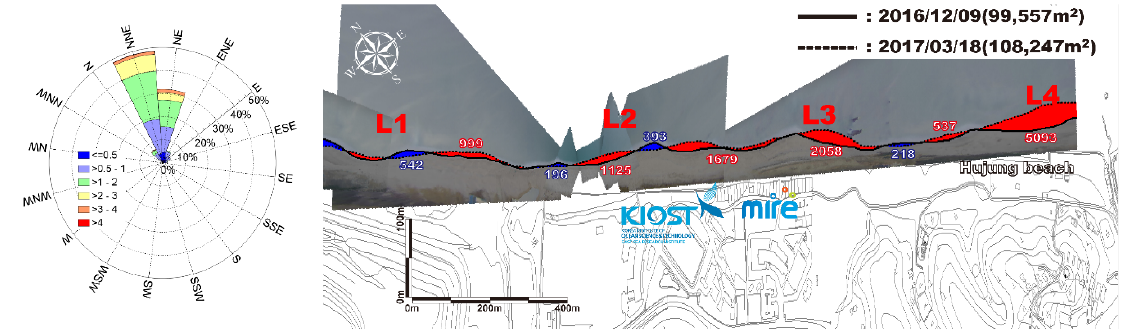
Figure 6. Comparison of y t between two di ff erent time steps measured at the beginning of T1 (9 December 2016) and at the end of T1 (18 March 2017) along the coastline. The red and blue colors filled in-between the two lines denote, respectively, the advance and retreat of the shoreline during T1. The numbers denote the magnitude of the gained and lost area in the corresponding colors (m 2 ). The rose diagram shows the H w and D w distributions measured during the period.